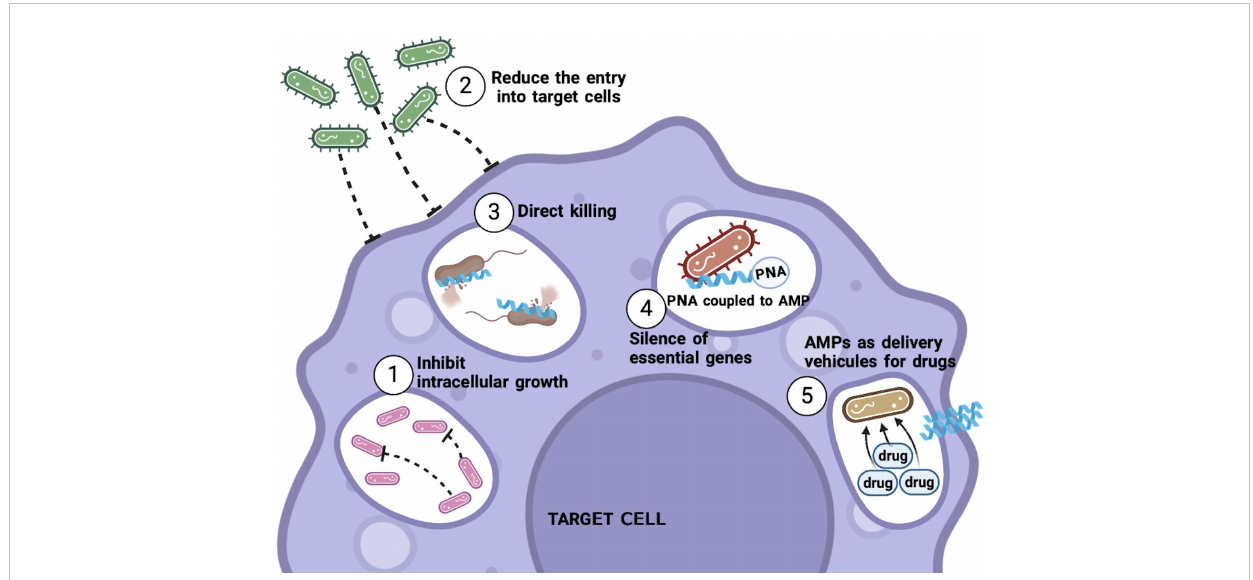
FIGURE 1 Mechanisms of action of AMPs against intracellular bacteria. AMPs can use different mechanisms to kill intracellular bacteria. Among these are the inhibition of the growth of the bacteria, as well as avoiding or reducing the entrance of the bacteria to the target cell, and the ability to penetrate the infected cell to kill the bacteria that are already inside. Thus, AMPs linked to different molecules can also be used as PNAs, to try to silence essential genes for the bacteria or attached with commonly used antibiotics to allow these drugs to enter the cell and be able to eliminate the bacteria.